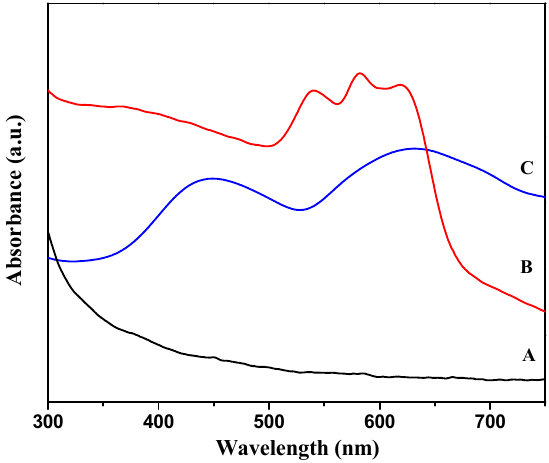
Figure 8. Diffuse-reflectance UV–vis spectra of (A) SAPO-5, (B) CoAPSO-5, and (C) CrAPSO-5 membranes corresponding to Figure 7.